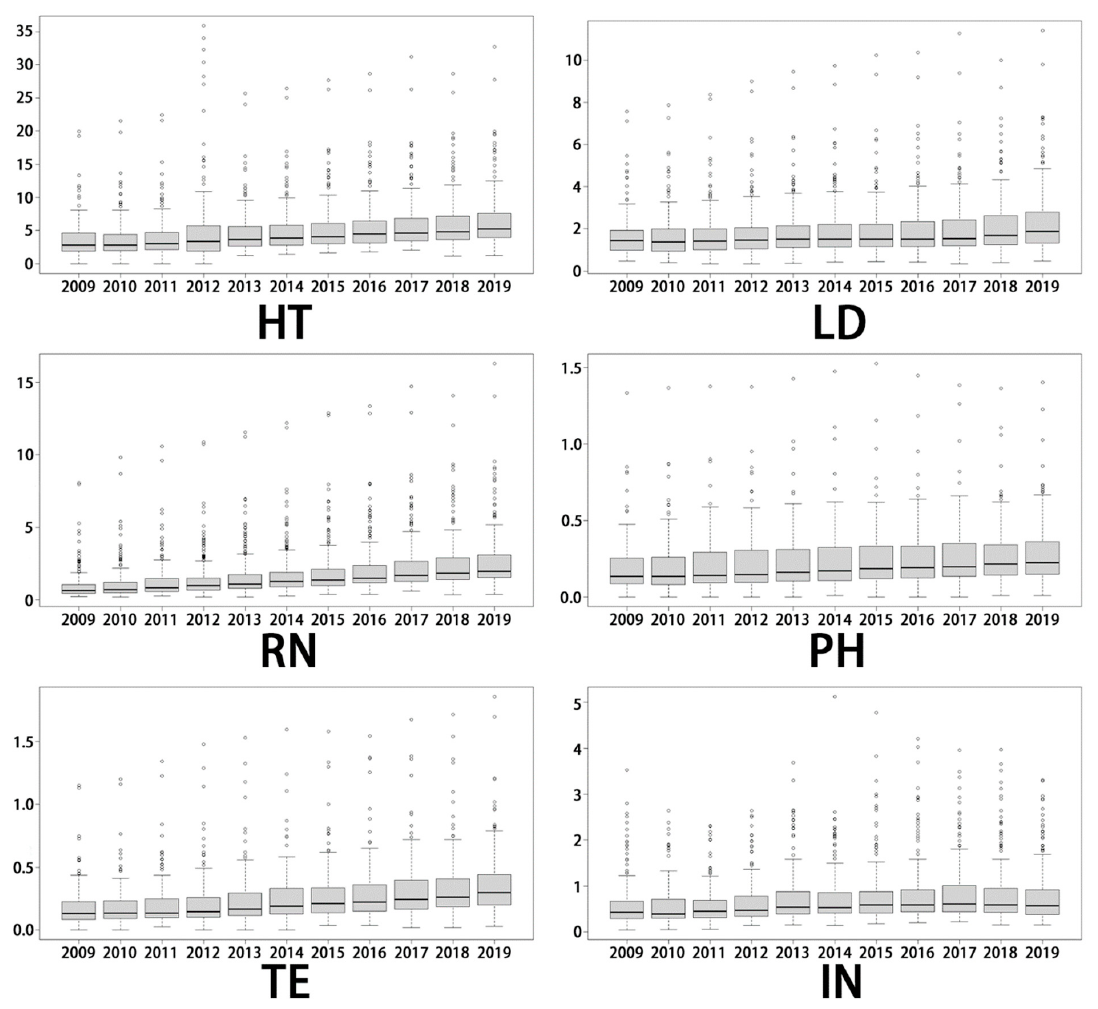
Figure 3. Box plots of the number of different types of healthcare professionals per 1000 people from 2009 to 2019. HT, health technician; LD, licensed doctor; RN, registered nurse; PH: pharmacist, TE: technologist, IN: intern.